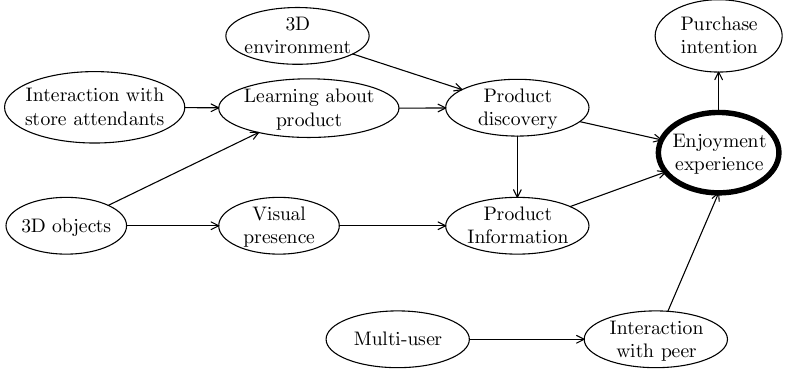
Figure 6. Conceptual framework of a consumer’s enjoyment experience created during